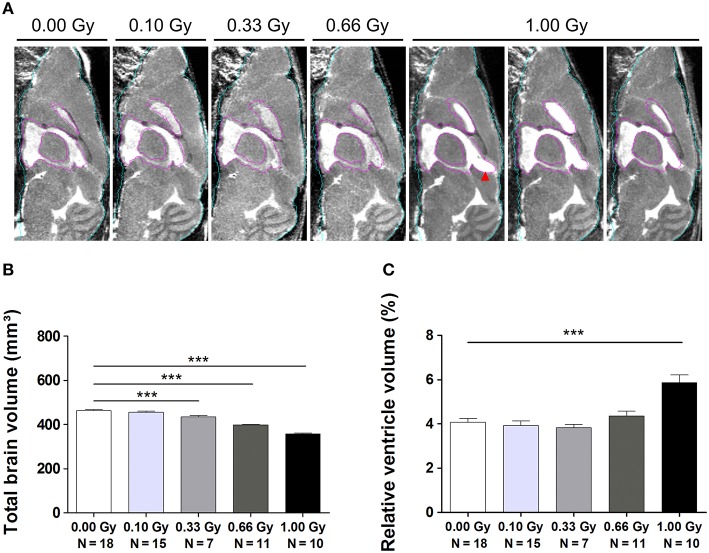
MRI unveils microcephaly and enlarged ventricles in in utero irradiated mice. (A) MIPs of representative MR images for all dose groups. The quality of atlas-based label propagation was visually verified using these MIPs. Whole-brain outline is shown in cyan, the delineation of the lateral and third ventricles is presented in purple. Animals irradiated with 1.00 Gy typically demonstrated a swelling of the dorsal part of the third ventricle (red arrowhead). (B) Total brain volume decreased drastically depending on the radiation dose, with a significant decline already observed in 0.33-Gy exposed mice. (C) Ventricles of animals prenatally exposed to 1.00 Gy were increased in size in relation to the total brain volume. Data are presented as mean ± SEM. Horizontal lines with an asterisks indicate significant differences between means of two groups. ***P < 0.001. The number of animals used is indicated in the graphs (N). Gy: Gray. MIP: maximum intensity projection. MRI: magnetic resonance imaging.